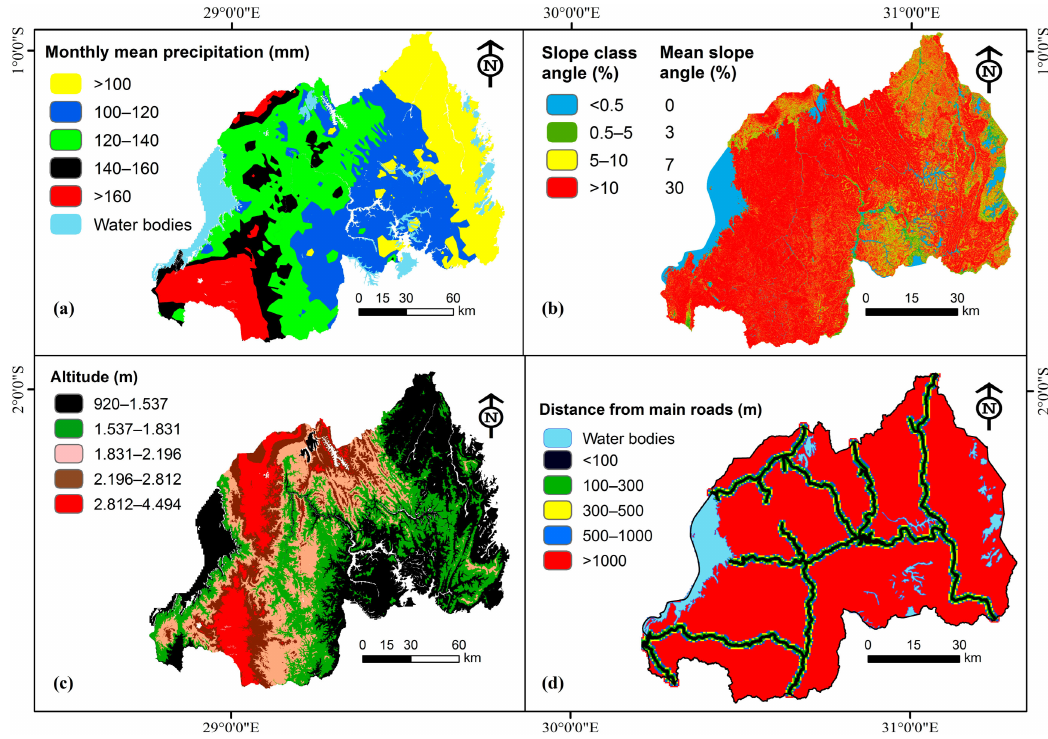
Figure 6. Landslides conditioning factors: ( a ) monthly mean precipitation, ( b ) slope, ( c ) altitude and ( d ) distance to main